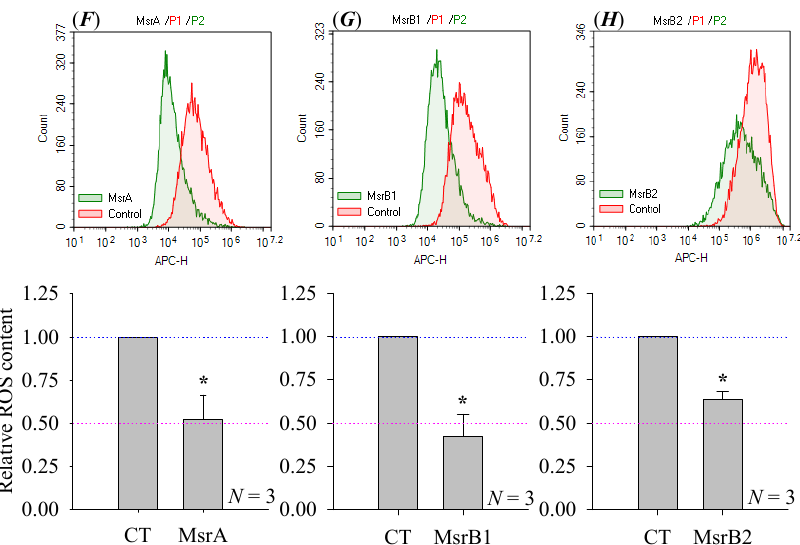
Figure 3. Msr over-expression enhanced ATP-stimulated calcium increases but suppressed reactive oxygen species production in pancreatic stellate cells. At 24 h after adenovirus transfection of GFP ( A ) or MsrA ( B ), MsrB1 ( C ), MsrB2 ( D ), rat pancreatic stellate cells were detached, loaded with Fura-2 AM, attached to Sykes-Moore perfusion chamber on Cell-Tak-coated glass bottom and perfused with ATP 10 μ M as indicated by the horizontal bars. ATP-induced calcium responses were quantified by integrating the calcium peaks (from 5–15 min, above the basal levels) and plotted ( E ). Comparisons were made between control (GFP, A ) and MsrA ( B ), MsrB1 ( C ), MsrB2 ( D ) over-expressing pancreatic stellate cells. Asterisks (*) indicate statistical significance at p < 0.05 ( N = 3). Color-coded calcium tracings in ( A – D ) are each from individual pancreatic stellate cells from a representative experiment. At 36 h after adenovirus-mediated over-expression of MsrA ( F ), MsrB1 ( G ) or MsrB2 ( H ), rat pancreatic stellate cells (14 days in culture in total) were incubated with CellROX (5 μ M) for 30 min (37 °C), fluorescence was detected by flow cytometry (typical charts shown in upper panels) and plotted (lower panels) ( F – H ). Asterisks (*) indicate statistical significance at p < 0.05, N = 3. Note the thin blue and pink horizontal dashed lines (lower panels in F – H ) which indicate the levels of 1.00 and 0.50 on the ordinate respectively.